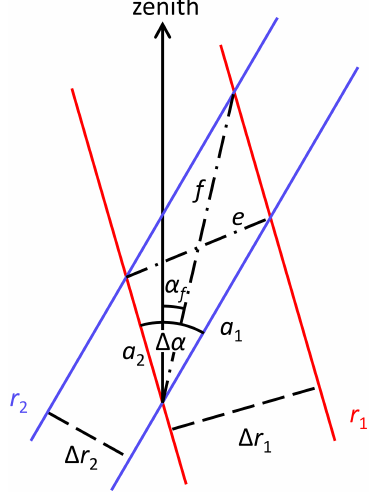
Figure B1. Calculation of mispointing